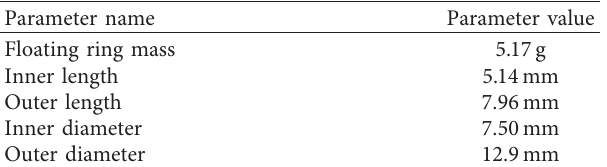
Table 5: Parameters of floating ring bearing that supported the rotor